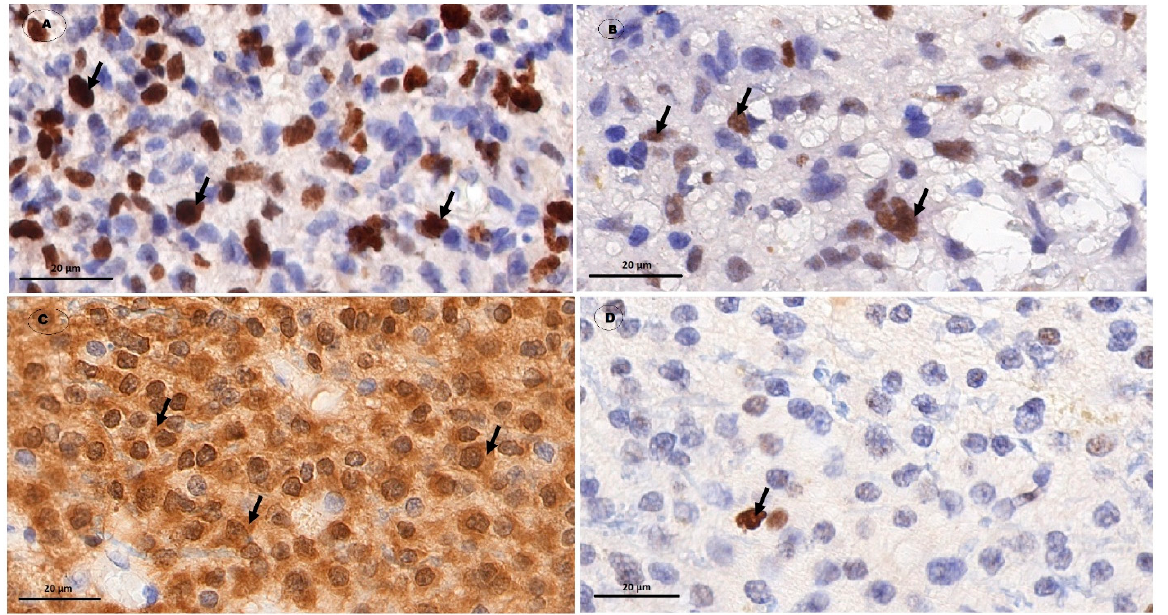
Figure 1. Immunohistochemical study of glial tumor markers. Magnification ×1000, Bar: 20 μ m. ( A ) Level of nuclear non-histone protein, a marker of Ki-67 cell proliferation in Grade IV glioblastoma material. The pronounced, diffuse, brown nuclear staining (arrows) shows an antigen-antibody binding reaction (up to 50% of cells in hot spots), indicating a high Ki-67 proliferation index. ( B ) Presence of p53 marker in Grade III anaplastic astrocytoma material. The moderately pronounced, diffuse nuclear staining (arrows) shows an antigen-antibody binding reaction, indicating the presence of p53 mutant protein. ( C ) Presence of IDH1 mutation in Grade II diffuse astrocytoma material. The cytoplasm with moderately pronounced, diffuse, brown staining shows an antigen-antibody binding reaction (arrows), indicating the presence of an IDH1 mutation. ( D ) Presence of MGMT methylation in Grade II diffuse astrocytoma material. Pointwise (less than 10% of cells) the brown nuclear staining (arrow) shows an antigen-antibody binding reaction, indicating the presence of MGMT promoter methylation.